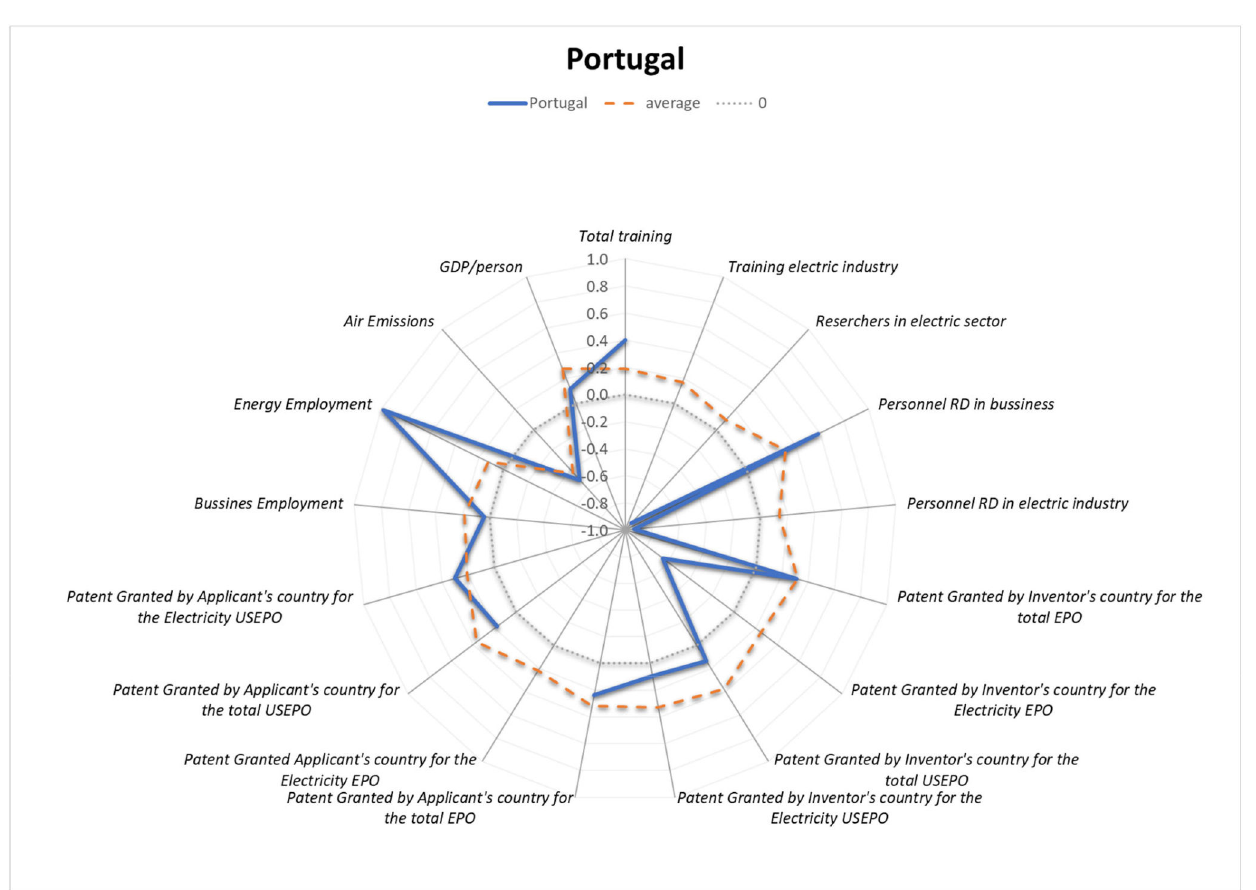
Figure 30. Synergy and trade-off occurrence—PT. Source: Authors’